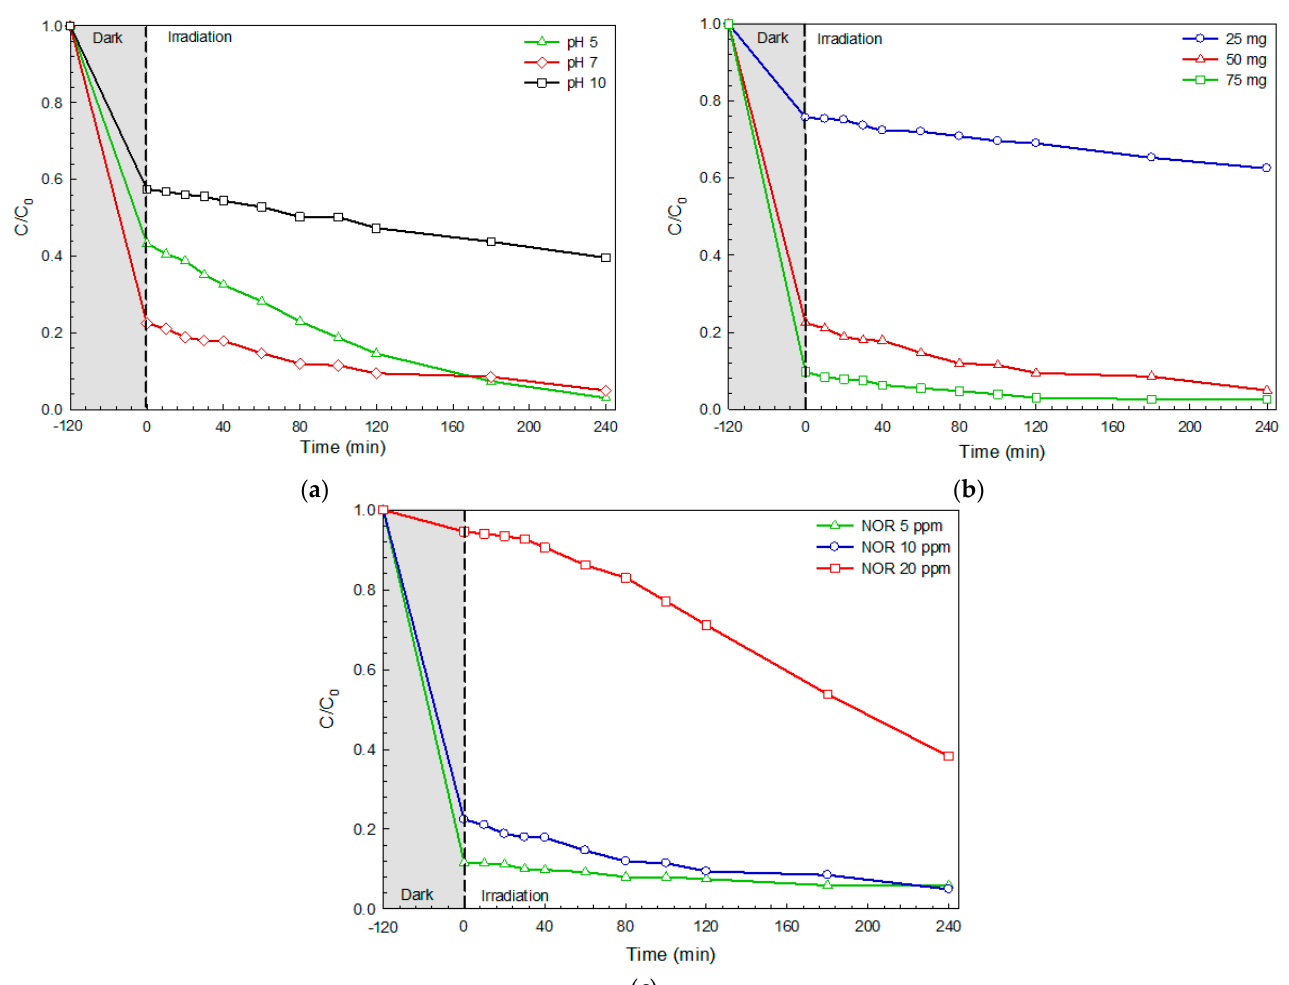
Figure 6. The effect of initial solution pH ( a ), photocatalyst content ( b ), and dye concentration ( c ) on the efficiency of the degradation of RhB dye.